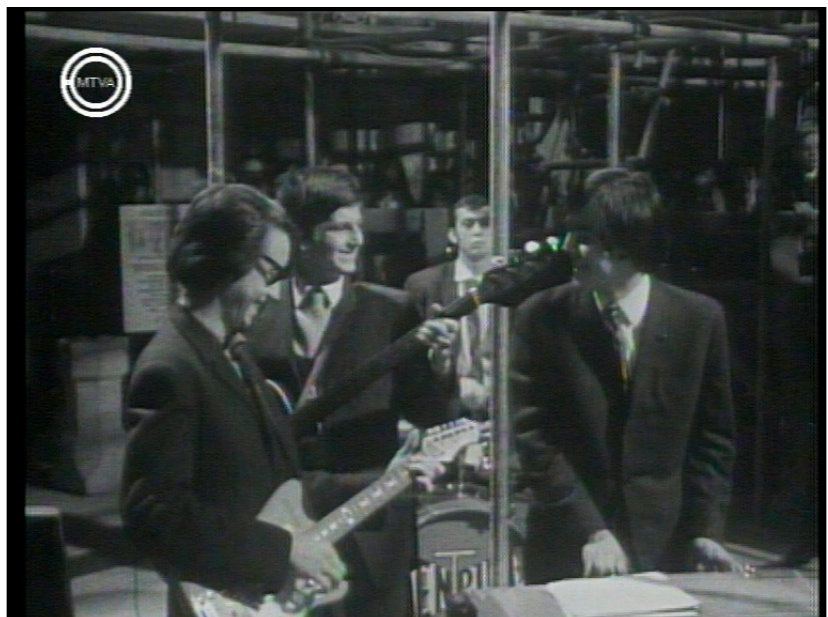
Figure 1. The photograph is a still image from MTVA (Hungarian Television Archives) and depicts the first beat mass from the Matthias Church.